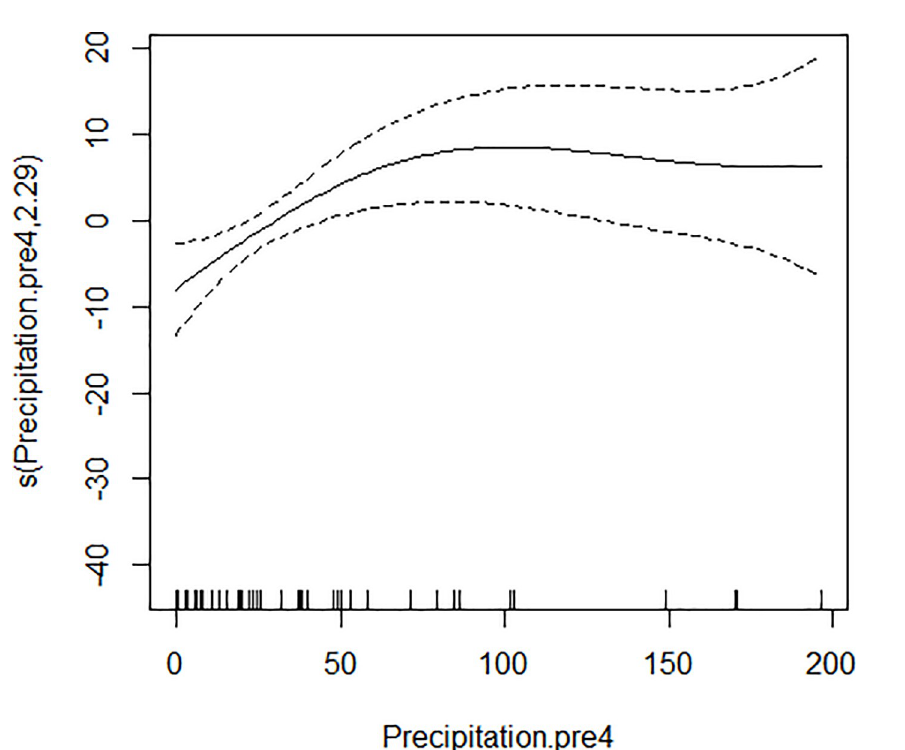
Fig 7. The relationship between HI and precipitation pre 4 weeks.